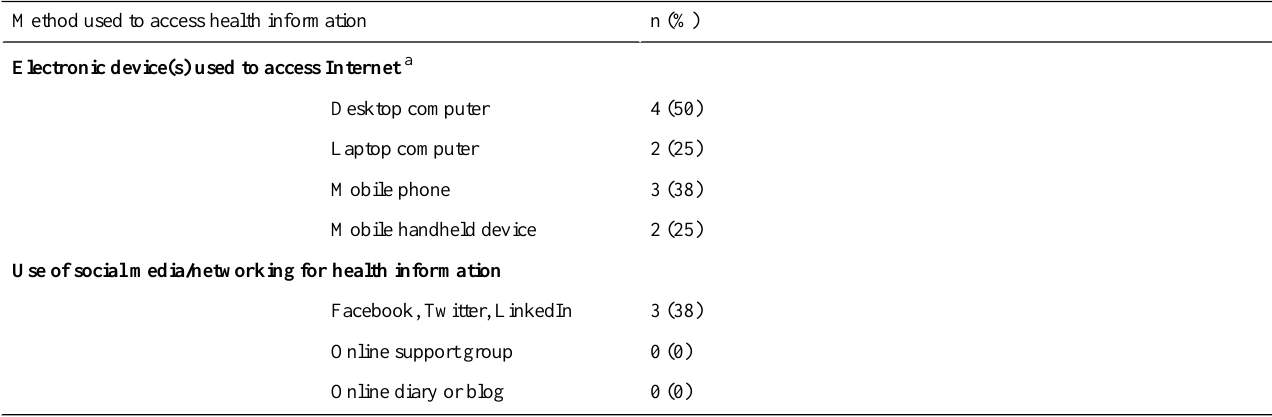
n (%)Method used to access health information